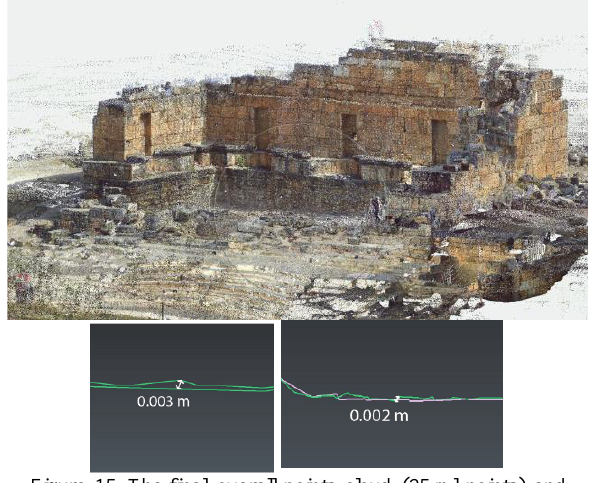
Figure 15. The final overall points cloud (25 ml points) and (below) very low distances among profiles extracted from different scans.